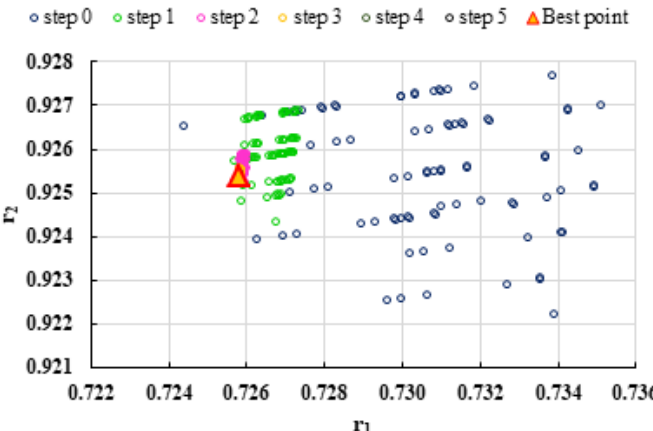
Figure 5. Distribution of P cen ( r 1 , r 2 ) points for each step of searching for the k-NN method for the conditions imposed by MC2.